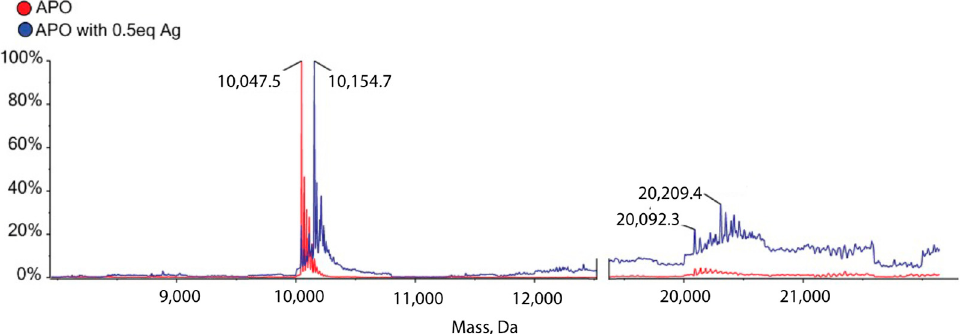
Figure 6. Deconvoluted ESI–MS of apo protein (red) and silver metalated protein (blue). Peaks labeled from left to right correspond to masses matching the monomer, the monomer with one silver, the dimer, and the dimer with one silver. The Y-axis represents relative intensity of the observed ions.